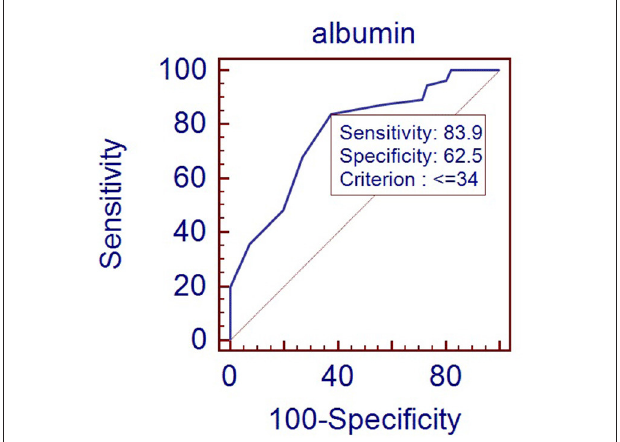
FIGURE 1 | ROC curve for albumin level predicting RDS in late-preterm infants (Area under curve: 0.77, p < 0.001).